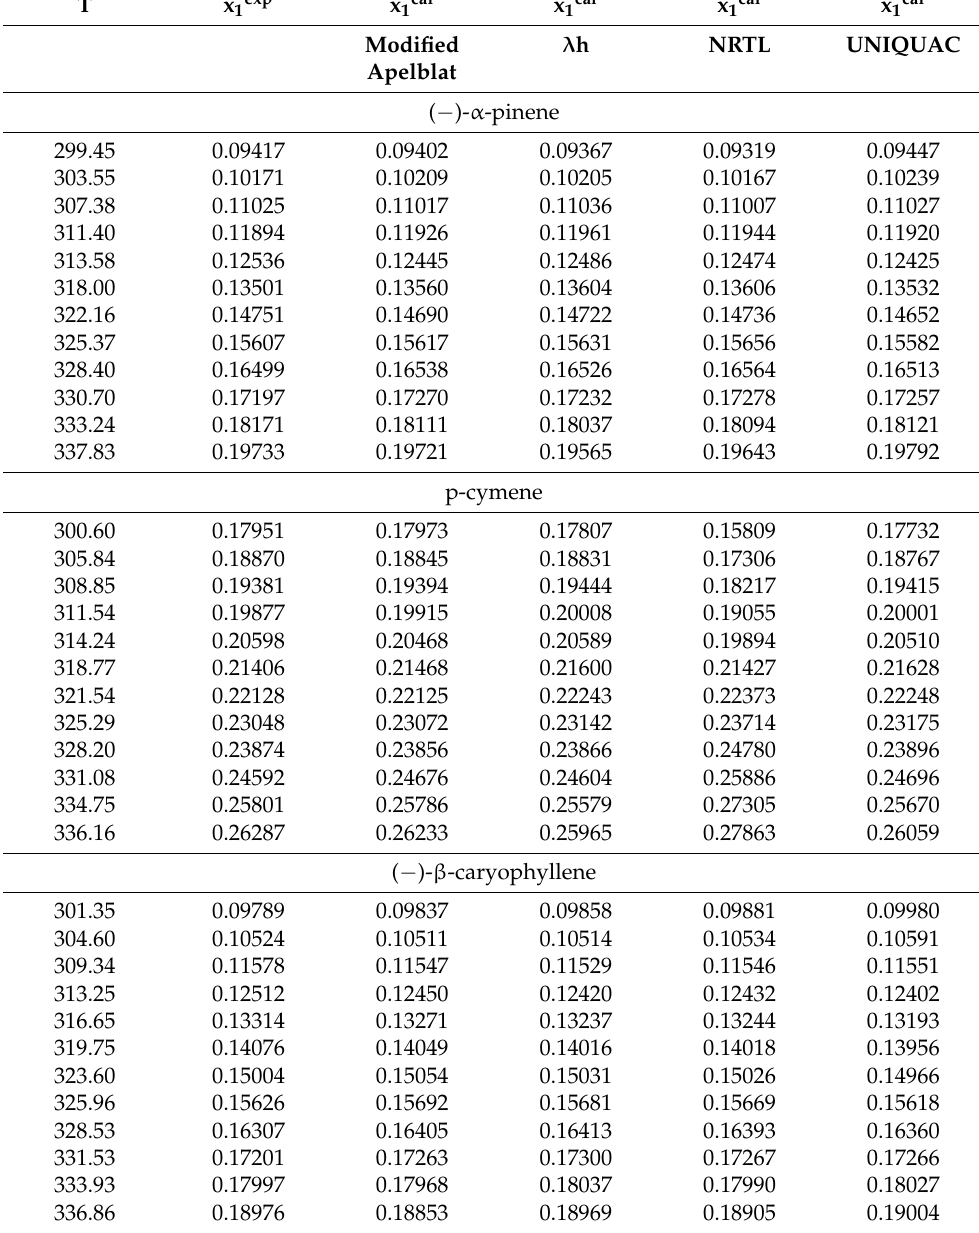
Table 1. Values of experimental mole-fraction solubility ( x 1 exp ) and calculated solubility data ( x 1 cal ) of dehydroabietic acid in monosolvents (( − )- α -pinene, p-cymene, and ( − )- β -caryophyllene) at different temperature T and pressure P = 101.3 kPa a .